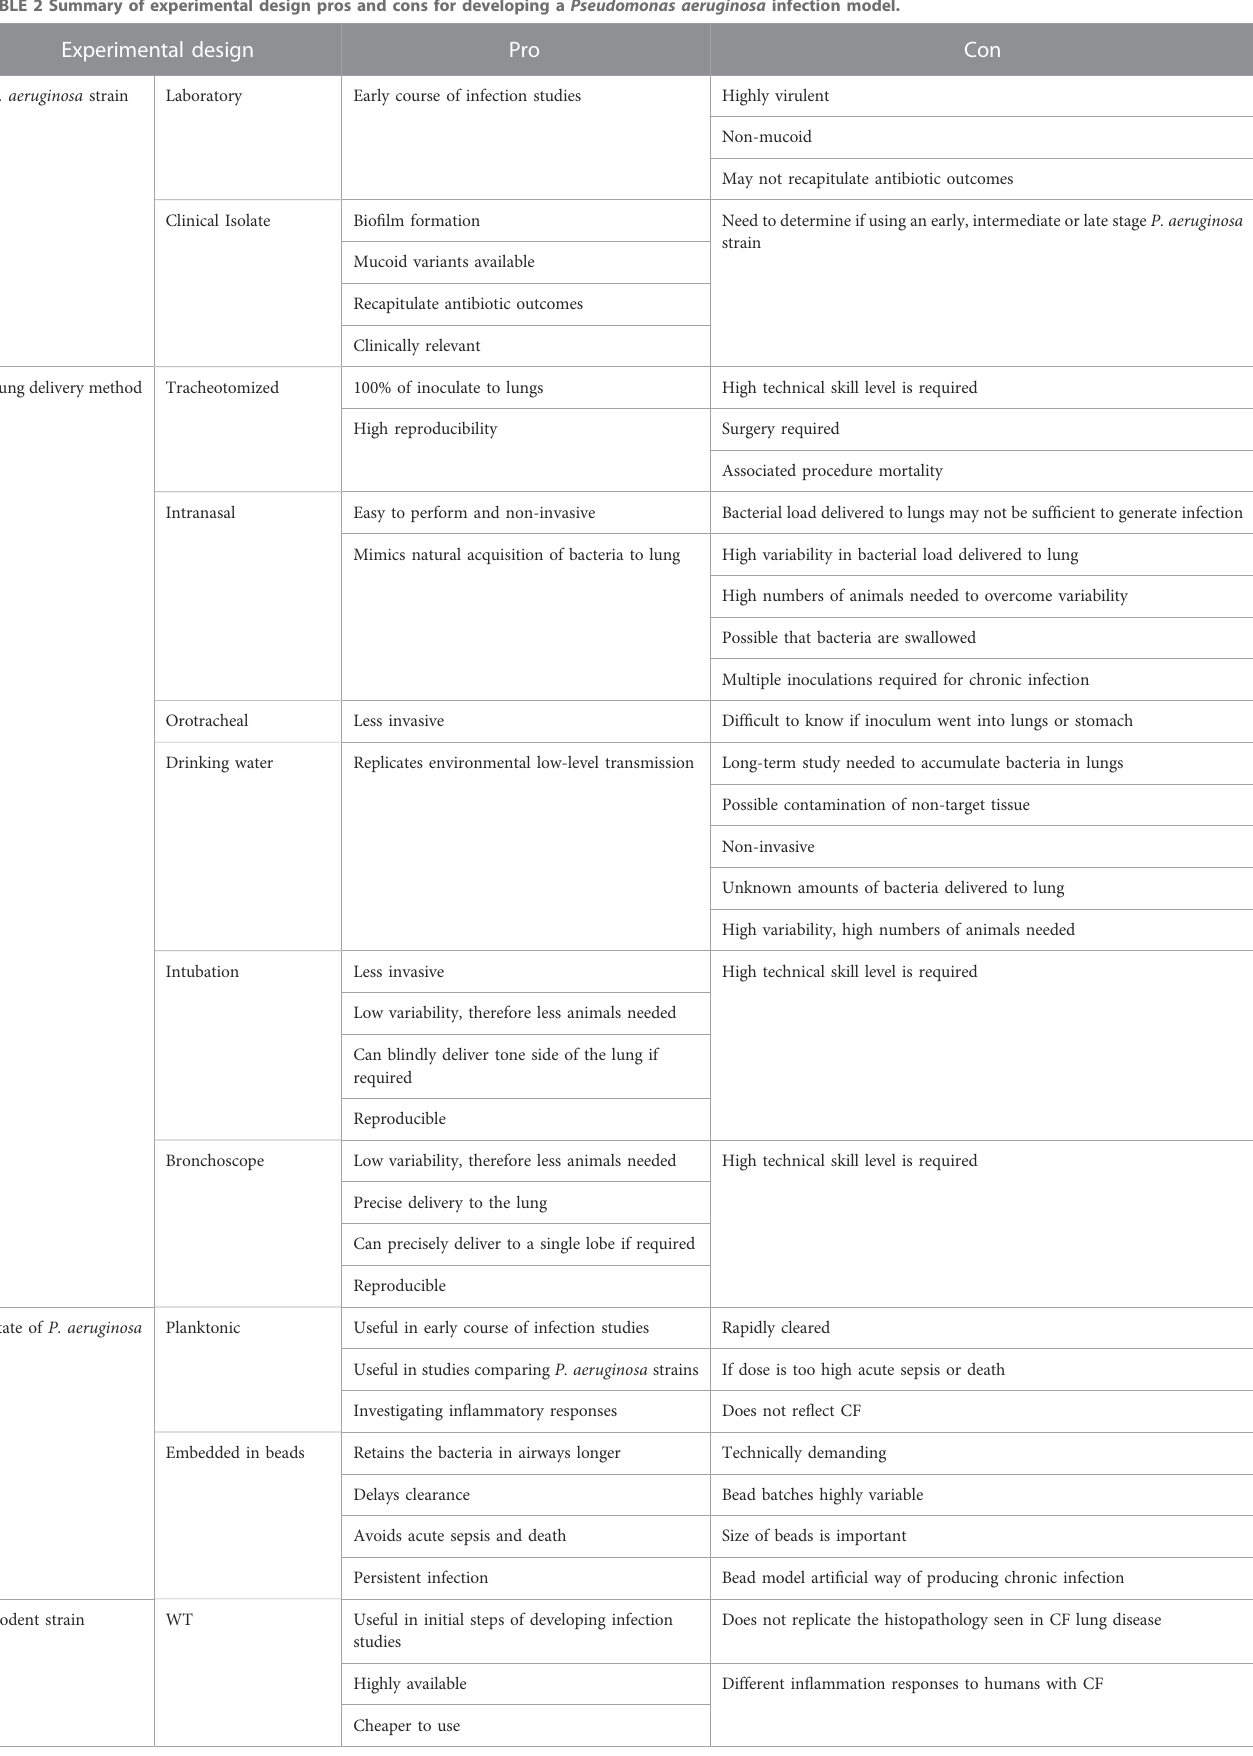
TABLE 2 Summary of experimental design pros and cons for developing a Pseudomonas aeruginosa infection